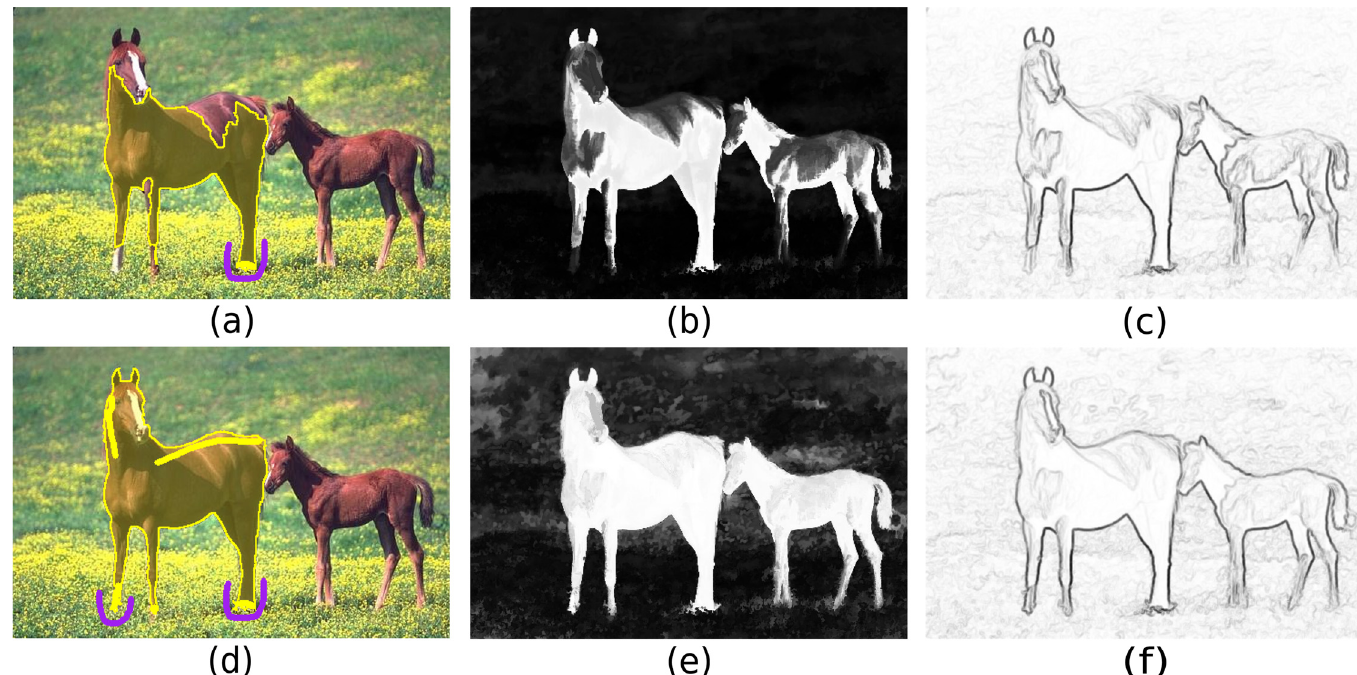
Fig 1. Example of interactive graph-based image segmentation. (a) The user draws labeled markers (a training set) inside and outside the object, and segmentation is based on optimum path competition from the markers in an image graph. (b) Image segmentation first relies on a pixel classifier, which is trained from the markers to create a fuzzy object map (the object should appear brighter than the background). (c) Second, the image is interpreted as a graph, whose arc weights should be lower on the border of the object than elsewhere. (d)-(f) The visual feedback from these results guides the user to the image location where more markers must be selected, improving fuzzy object map, arc weights, and so segmentation along a few interventions.